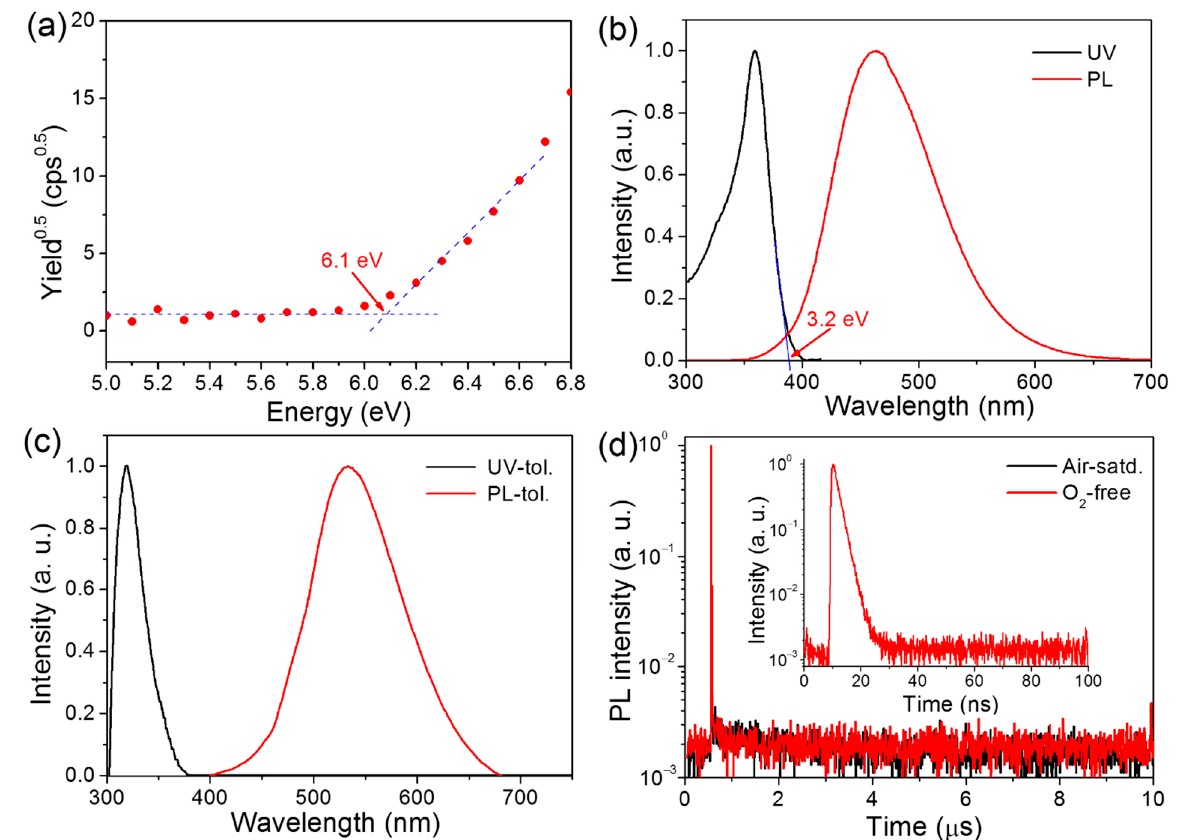
Figure 2. ( a ) The HOMO energy level of HAP-3FDPA determined by atmospheric ultraviolet photoelectron spectroscopy. ( b ) The UV and PL spectra of HAP-3FDPA in a neat film. ( c ) The UV and PL spectra of HAP-3FDPA in diluted toluene (tol.). ( d ) Transient PL decay of HAP-3FDPA in air-saturated (Air-satd.) and oxygen-free (O 2 -free) toluene. Inset: transient PL decay in a time range of 100 ns. Table 1. The photophysical properties of HAP-3FDPA and an 8 wt % HAP-3FDPA:mCP-doped film.